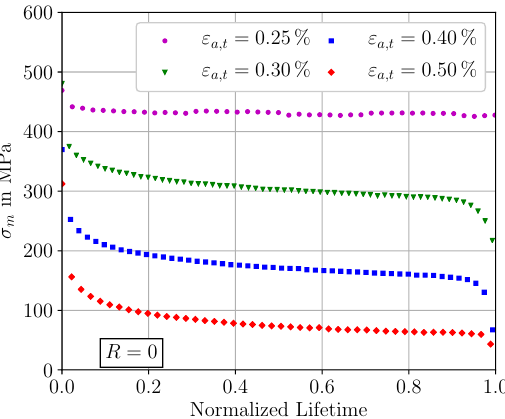
Figure 5. Experimental mean stress evolutions of SAE 4150 during cycling at different constant total strain amplitudes at R ε =